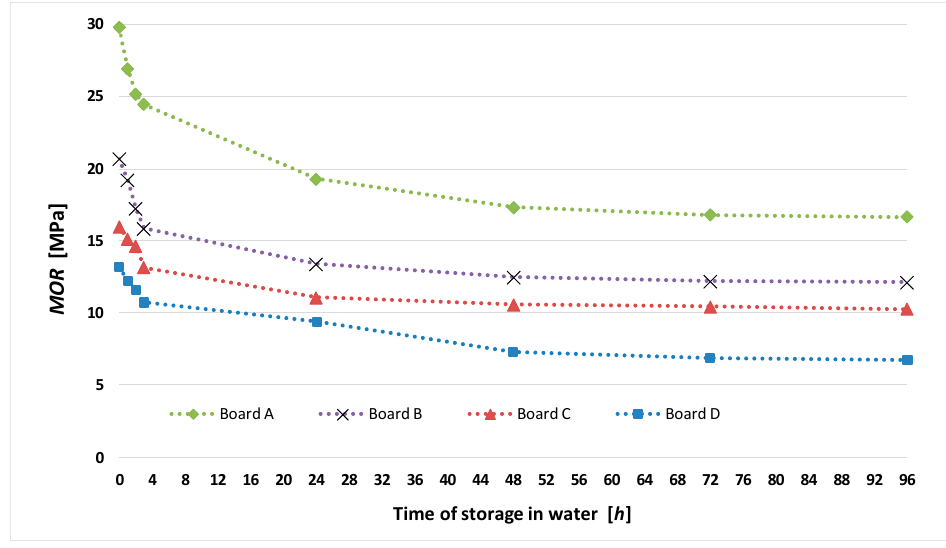
Figure 4. MOR of tested boards versus time of their storage in water.